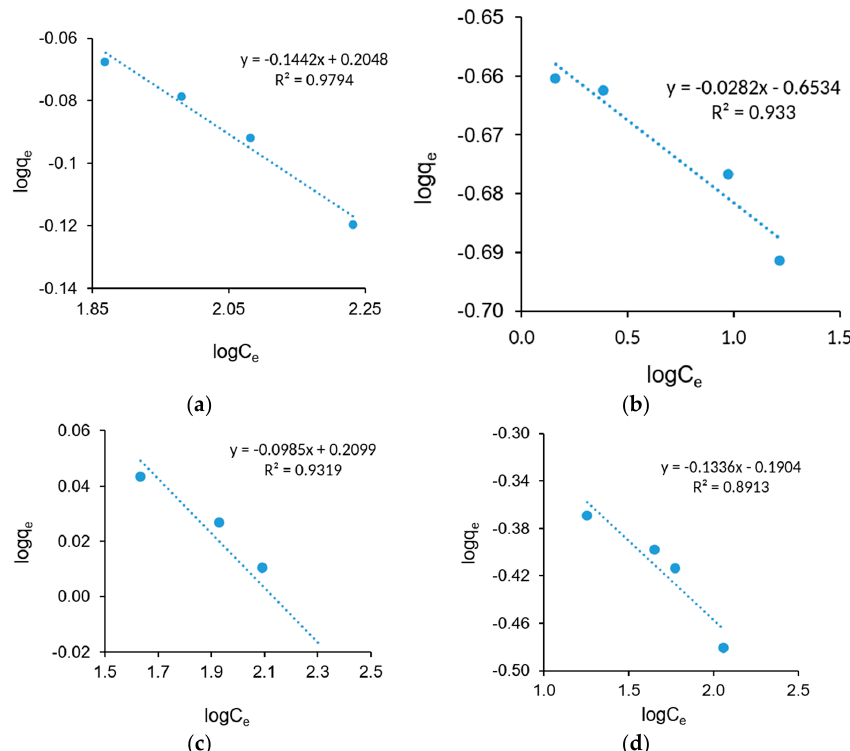
Figure 7. Freundlich adsorption isotherm modeling for the removal of ( a ) COD; ( b ) BOD; ( c ) SS; and ( d ) NH 3 from SRPE using FeSO 4 ·7H 2 O as a coagulant.